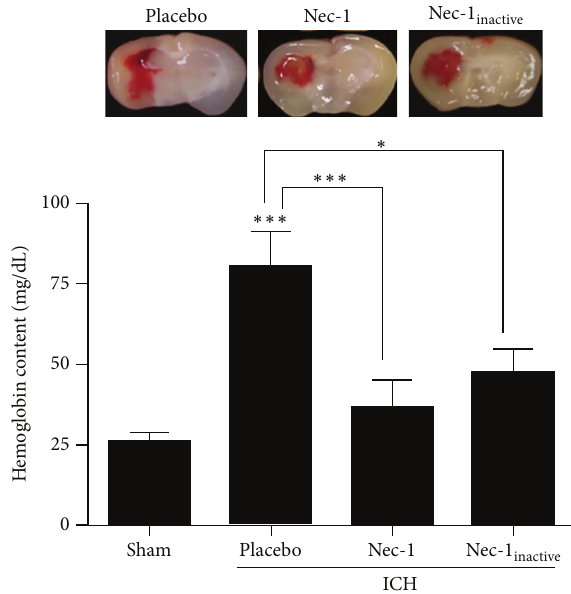
Figure 2: Nec-1 attenuates hematoma size after ICH. Nec-1 admin- istration at the time of injury reduced hematoma size at 72 h after ICH. Coronal brain images were prepared and digitally captured to visualize hematoma size (top panels). Hematoma volume was quan- tified by determining the hemoglobin content of each hemisphere at 72 hours after ICH (bottom panel). Data are expressed as mean ± SEM ( ∗ 𝑃 < 0.05 , ∗∗∗ 𝑃 < 0.001 ; 𝑛 = 10–14 per group). Nec-1 and were not significantly different from sham Nec- 1 inactive